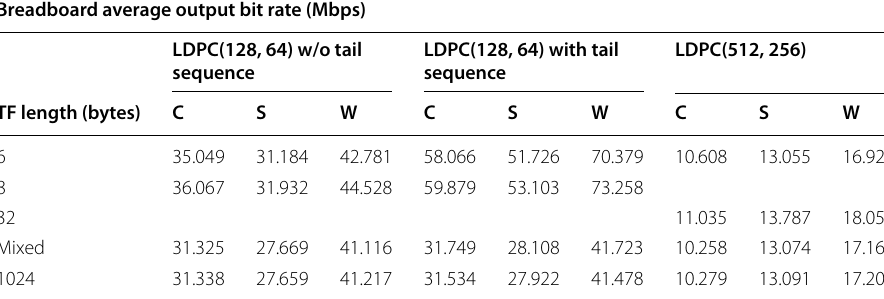
Table 9 Breadboard OBR performance of all critical modules for the LDPC codes (C SRAA, W Winograd) = Breadboard average output bit rate